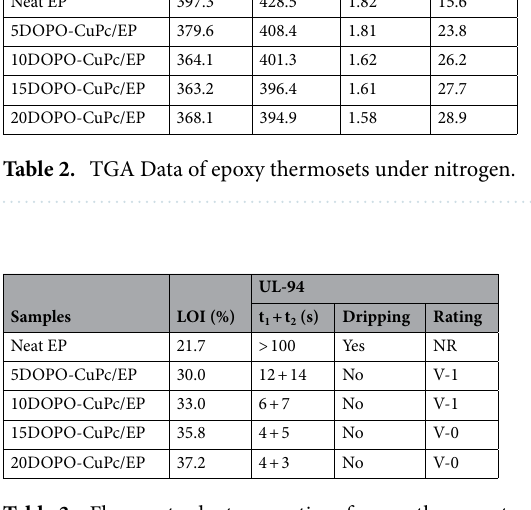
Table 3. Flame retardant properties of epoxy thermosets.